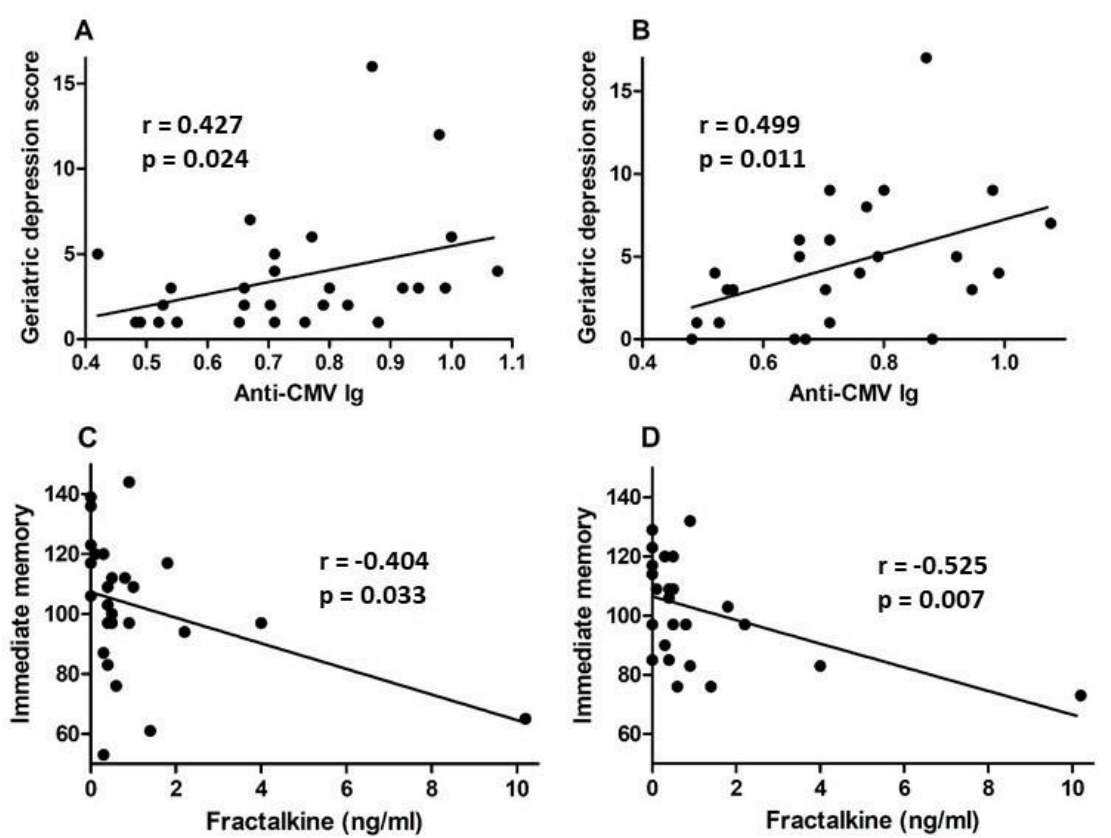
Figure 6. Comparison of visuospatial/constructional and language scores between groups of CMV-seropositive and -ser- onegative subjects at t1 and t2. ( A , C ) Following neuropsychological testing, visuospatial/constructional and language scores were calculated at t1 for all study subjects and ( B , D ) approximately 18 months later (t2) for all study subjects com- pleting follow-up. Error bars on graphs show median ± interquartile range for each group. No significant differences between CMV-seropositive and -seronegative groups were observed. Mann – Whitney U -test, ( A ) p = 0.429, ( B ) p = 0.708, ( C ) p = 0.701, ( D ) p = 0.450.